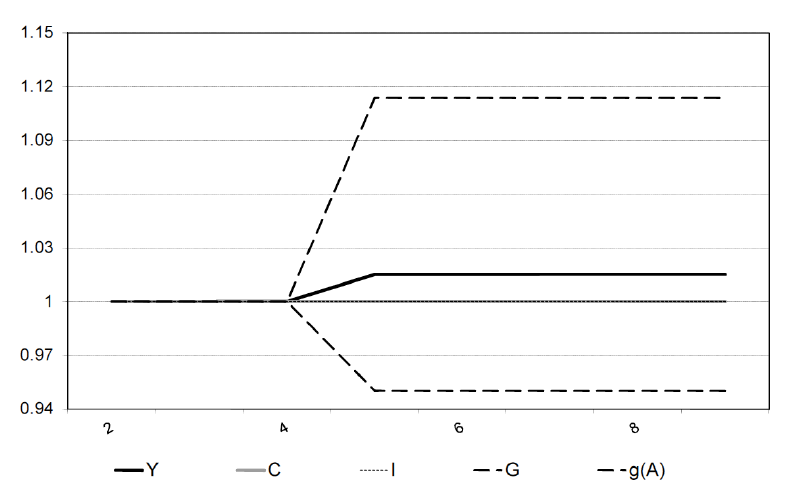
Figure 2. Effect of an increase in the carbon tax on the economy (Case 2)